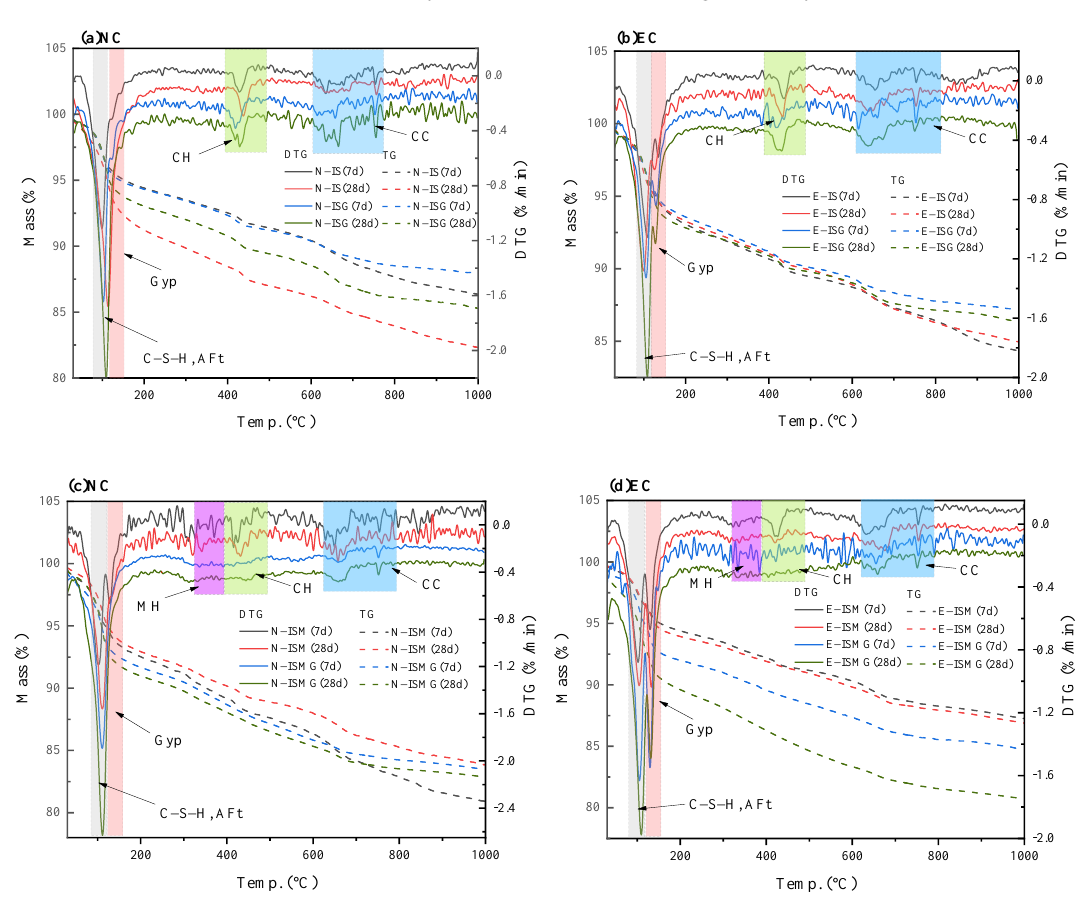
Figure 10. Results of TG/DTG for specimens immersed in distilled water and sulfate solution for 7 and 28 days: ( a ) N-IS and N-ISG, ( b ) E-IS and E-ISG, ( c ) N-ISM and N-ISMG, and ( d ) E-ISM and E-ISMG.